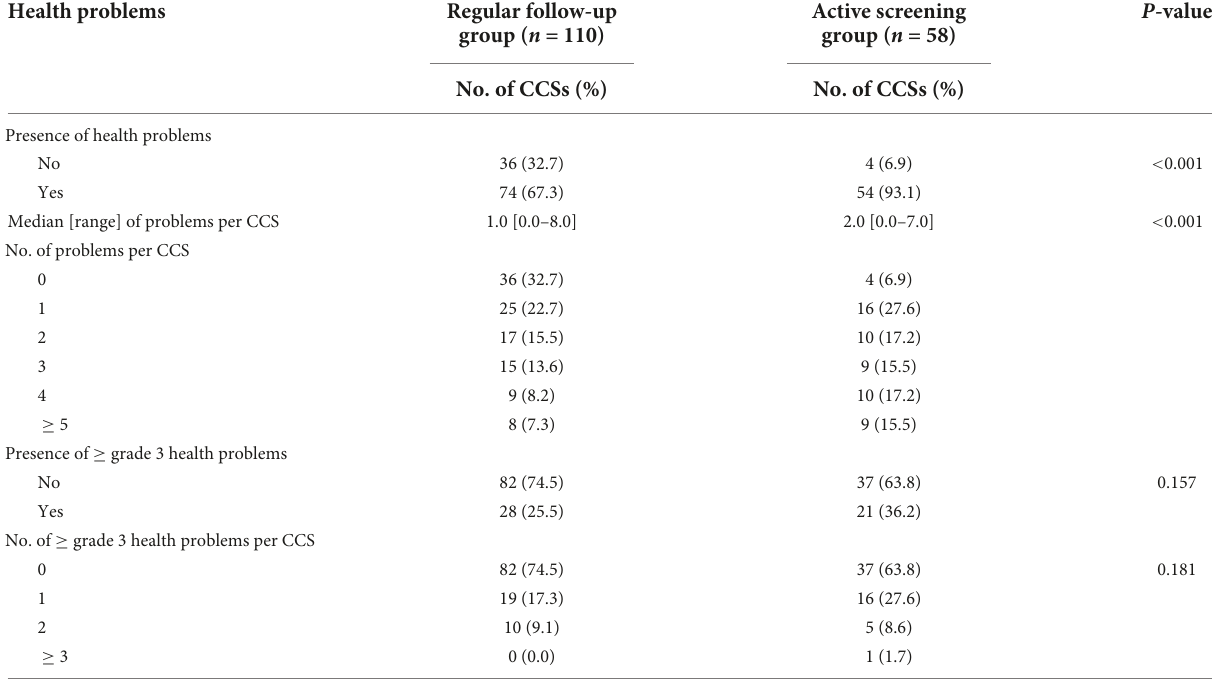
TABLE 3 Health problems in CCSs in regular follow-ups and active screening. Health